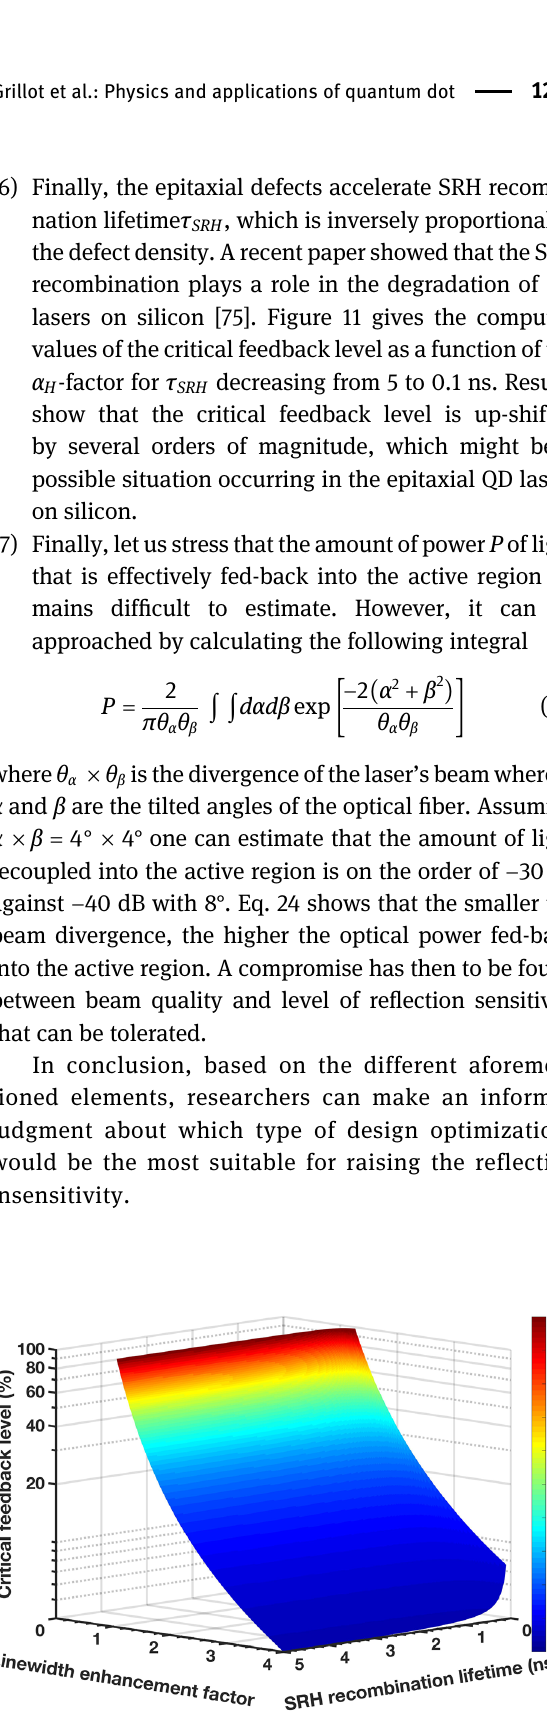
Figure 10: The damping factor ( γ ) as a function of the squared ) for epiaxial QD lasers on relaxation oscillation frequency ( f 2 Figure 11: The critical feedback level ( r crit ) as a function of the RO linewidth enhancement factor ( α H ) and SRH recombination silicon with facets ’ power re fl ectivities such as C/HR, 55/HR and 77/ HR, respectively. lifetime ( τ SRH )